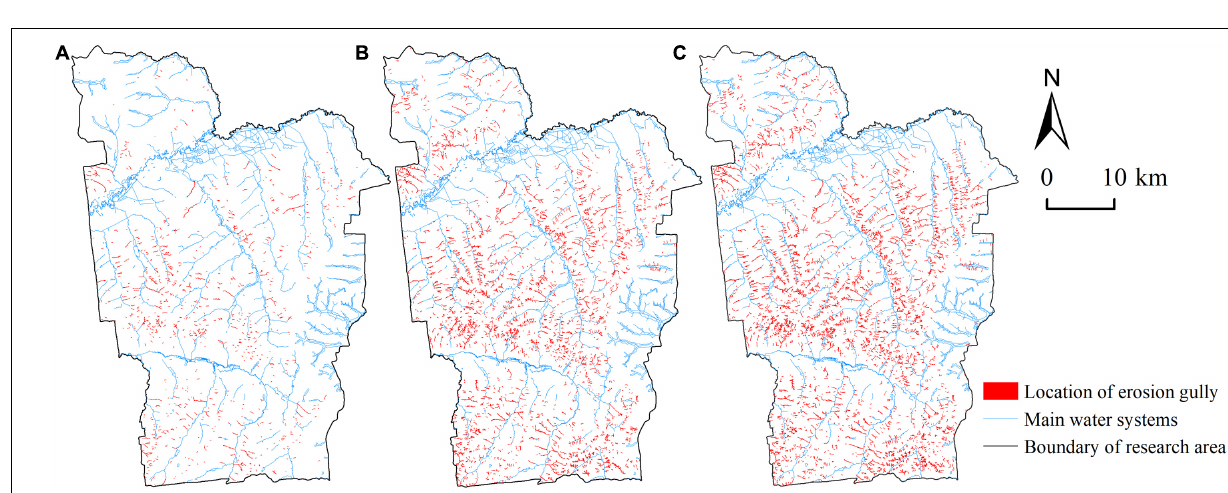
FIGURE 4 | Gully distribution in (A) 1965, (B) 2005, and (C) 2015.